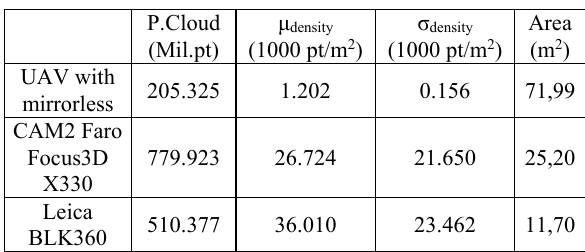
Table 2: Main specifications of the TLS and